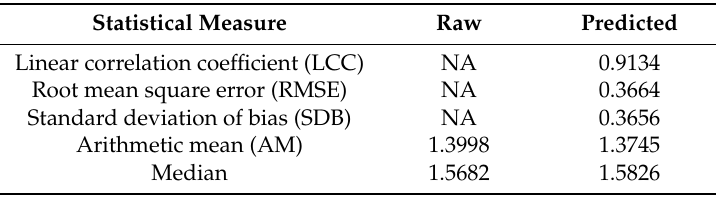
Table 2. Comparison of predicted and raw yearly log-transformed numbers of human brucellosis cases in the model development phase (2006–2008) in Inner Mongolia,